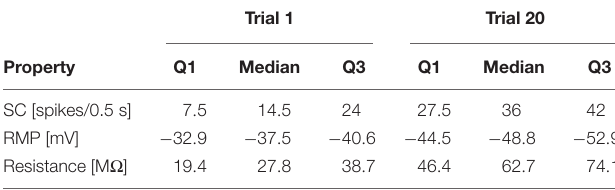
TABLE 3 | Absolute values for non-synaptic plasticity effects in T